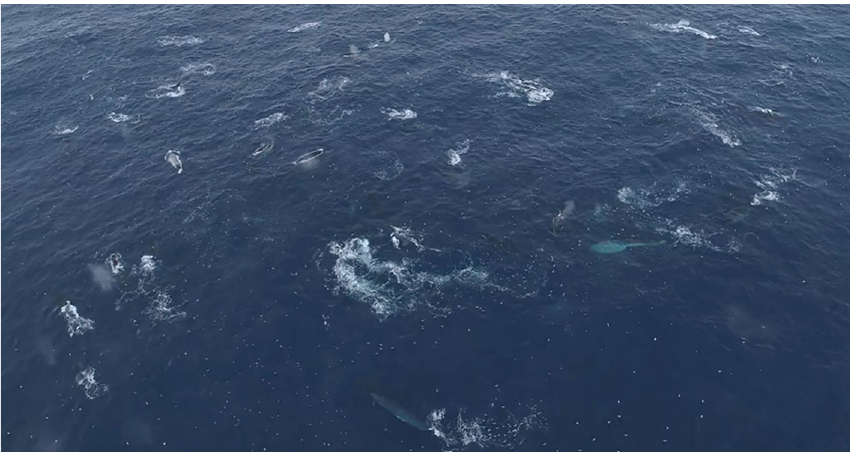
Figure 3. Fin whale feeding aggregation. Aerial view on a section of the active feeding aggregation of ~ 70 fin whales encountered during ship transit on RV Polarstern expedition PS112 in 2018, filmed by drone. ©BBC (OSM video 2).